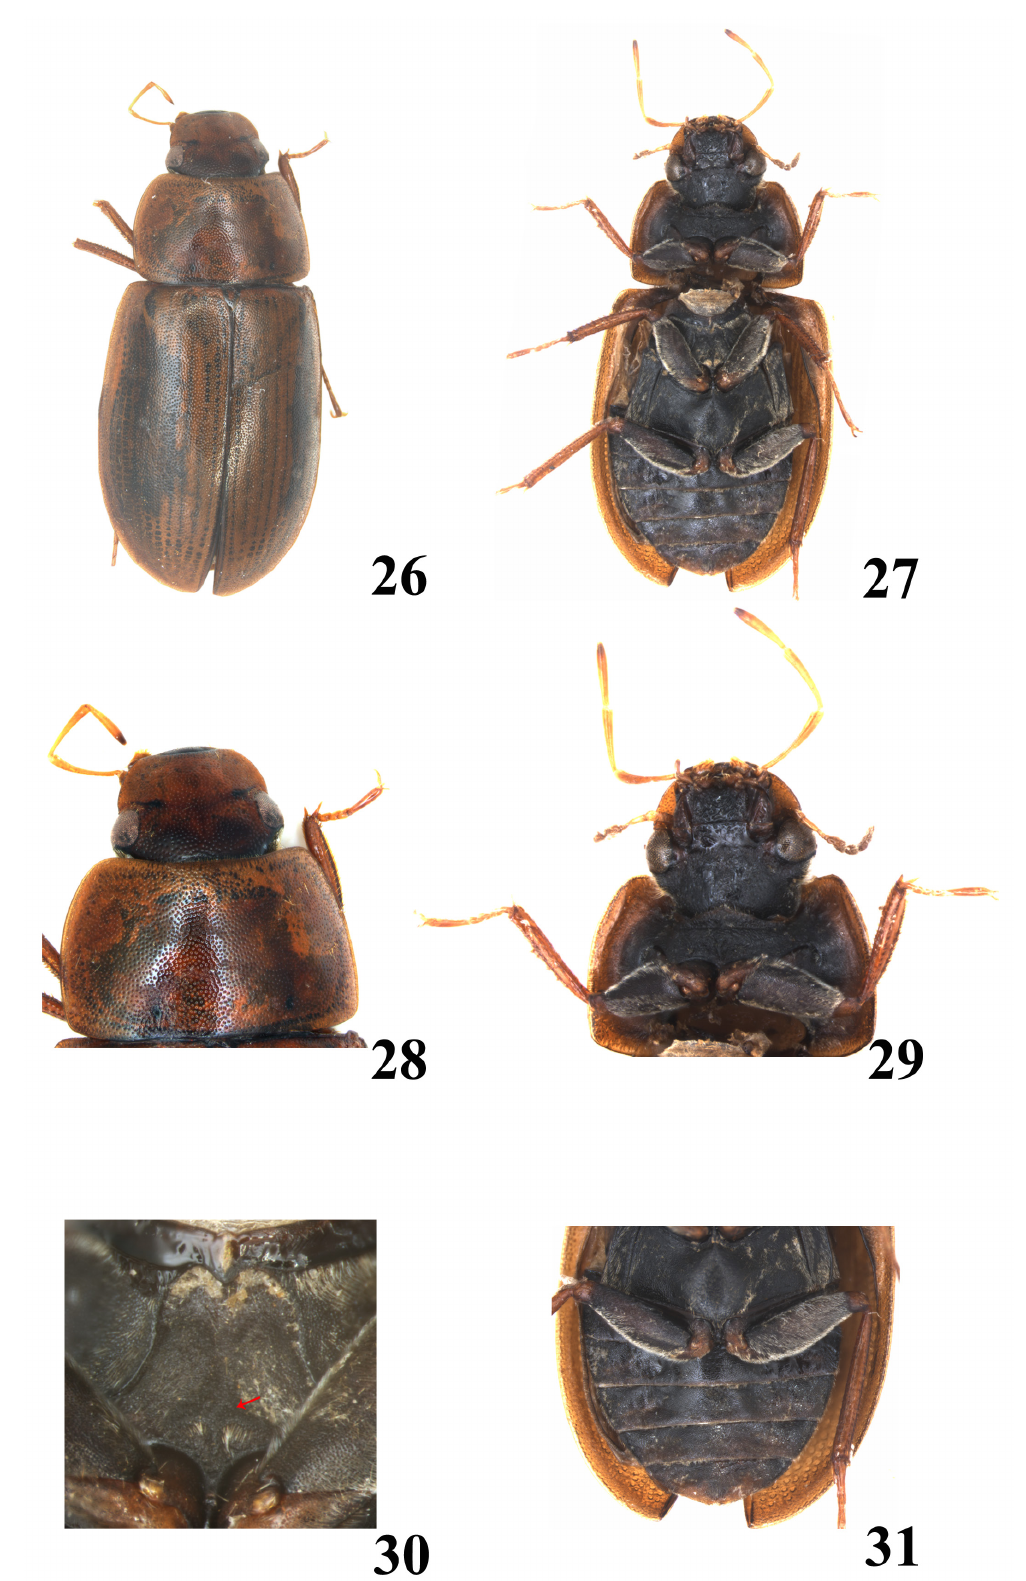
Figs 26–31. Helochares obscurus (Müller, 1776). 26–27 . Habitus. 26. Dorsal. 27. Ventral. 28 . Head and pronotum. 29 . Head and prosternum. 30 . Mesoventrite. 31 .